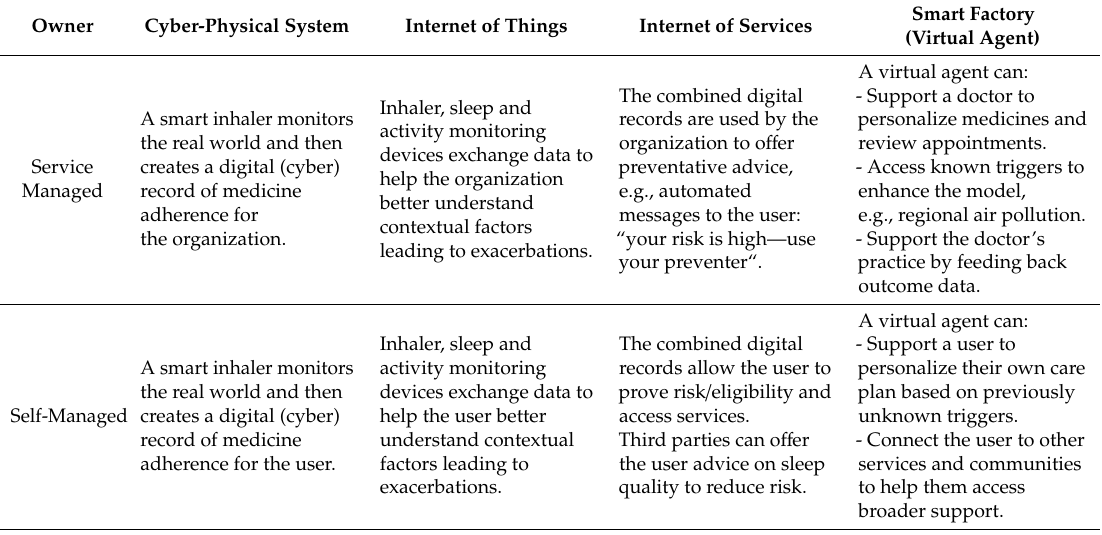
Table 2. Industry 4.0 toolset applied to asthma